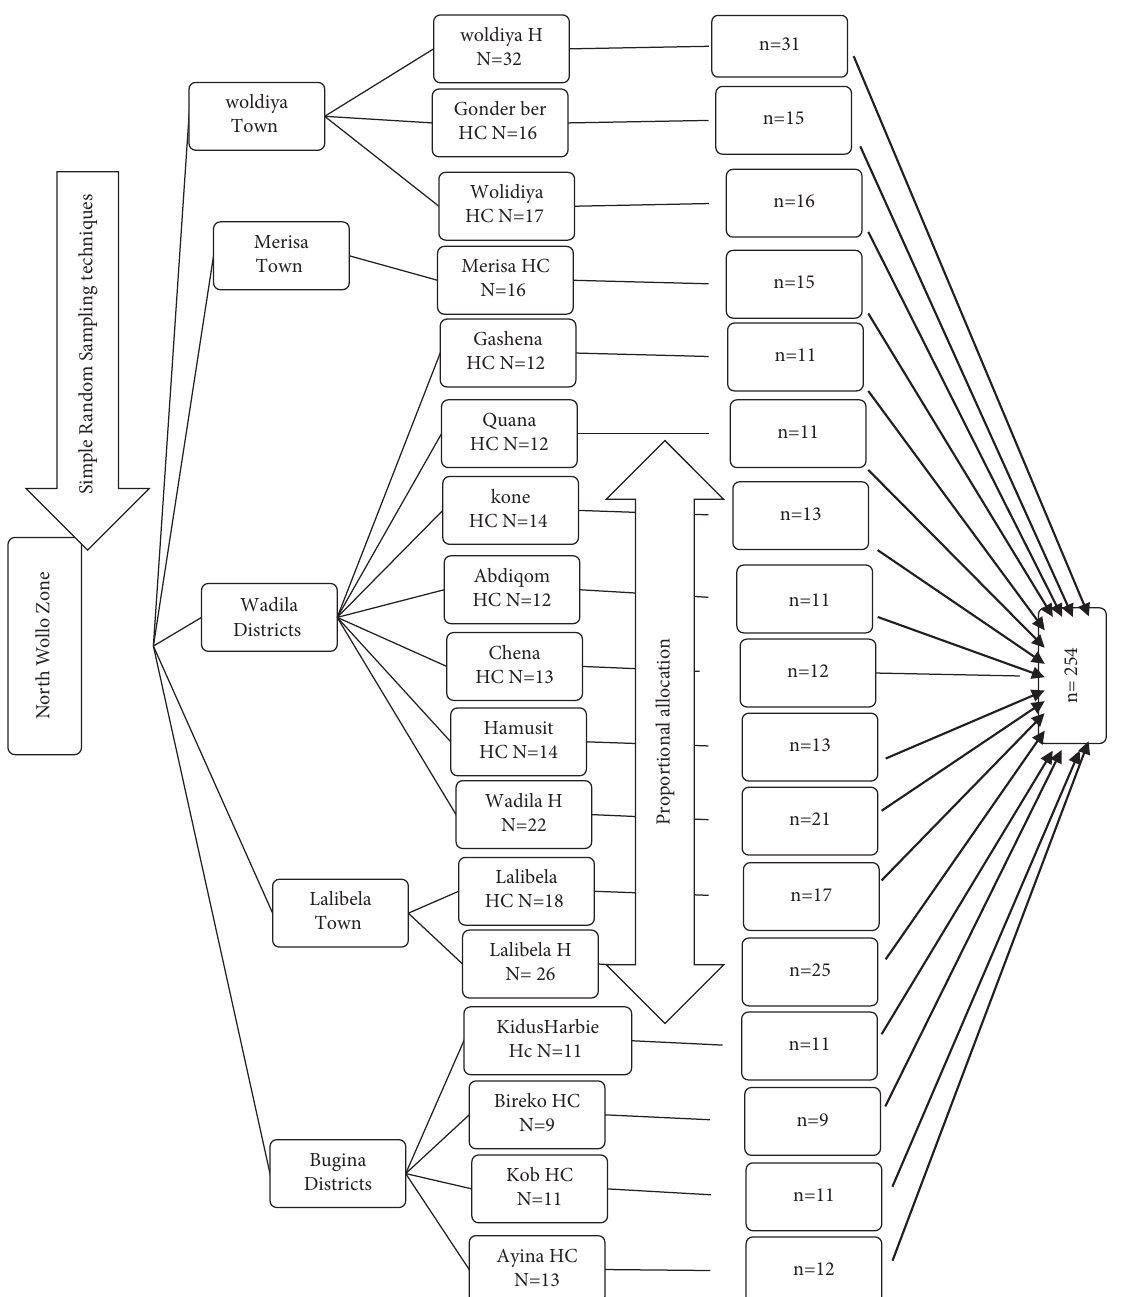
Figure 1: Schematic presentation of sampling procedure of the study. HC: health center, H: hospital, N: total number, n: